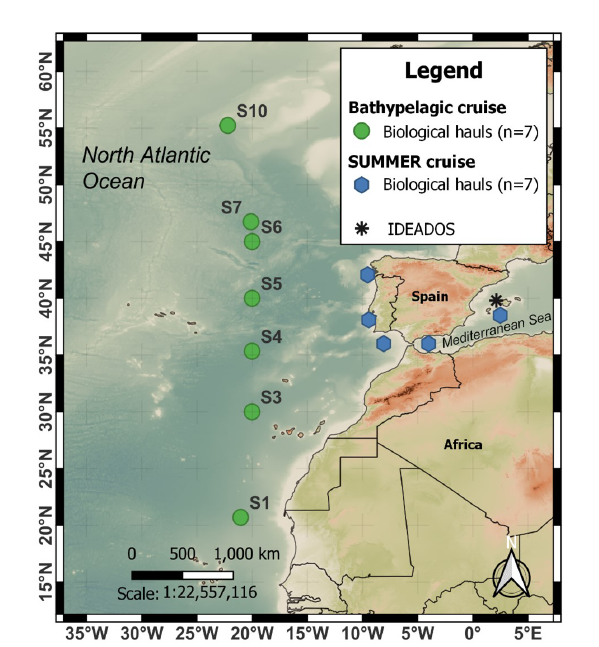
FIGURE 1 Sampling area and location of stations in the northeast Atlantic during the Bathypelagic (green dots) cruise and western Mediterranean during the SUMMER (blue diamonds) and IDEADOS (black asterisks) cruises on board the R.V. “ Sarmiento de Gamboa.